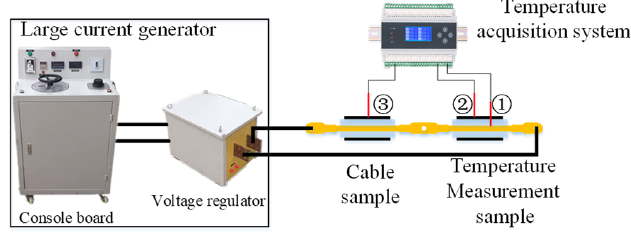
Figure 2. The overall accelerated thermal aging system.